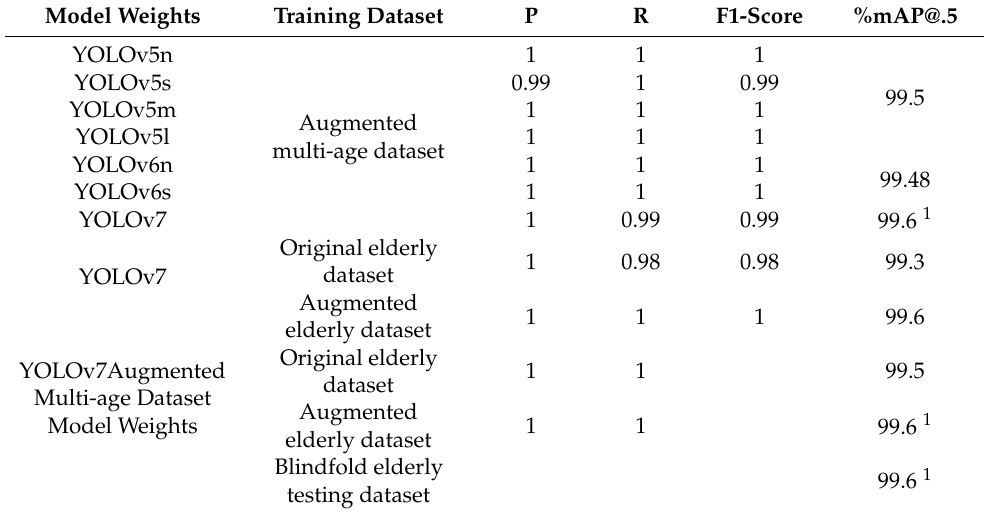
Table 2. Precision (P), recall (R) and mAP@.5 Results.